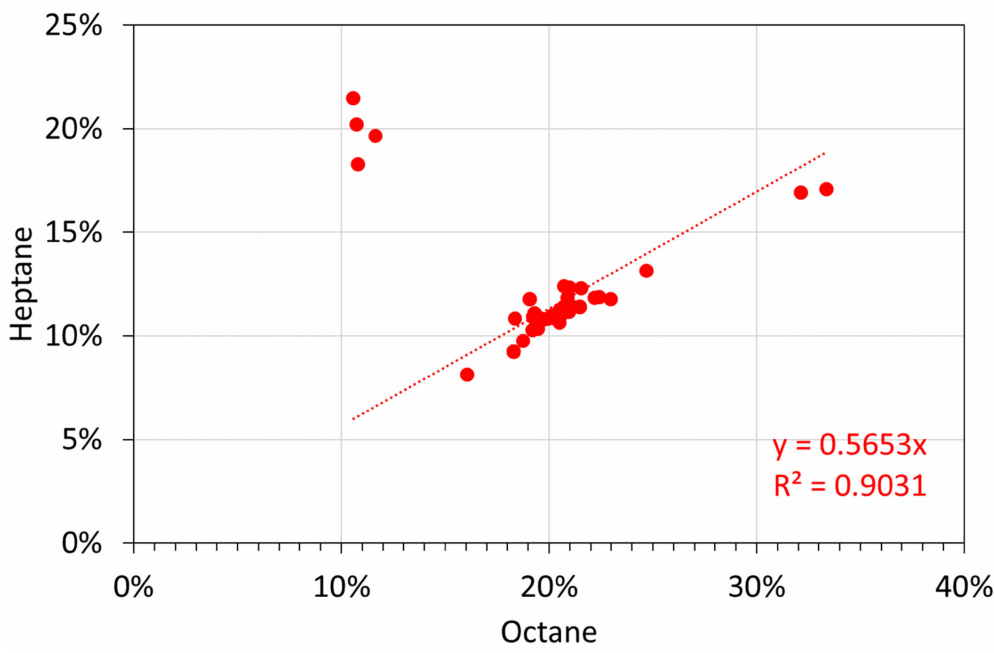
Figure A17. Molar alkane oil analyses: octane vs. heptane.